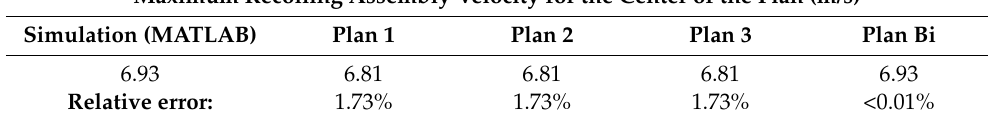
Table 11. The results of simulation compared to the results approximated by the obtained function for the center of the plan.